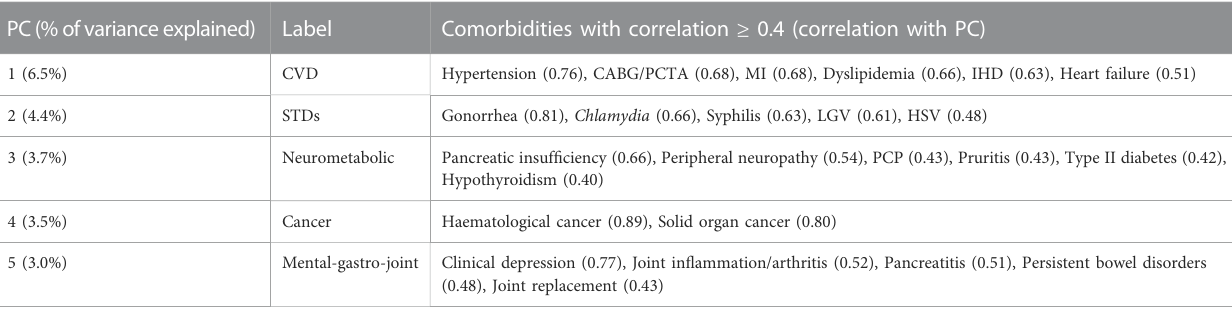
TABLE 2 Patterns identi fi ed using principal component analysis in all POPPY participants with HIV ( n = 1,073). PC (% of variance explained) Label Comorbidities with correlation ≥ 0.4 (correlation with